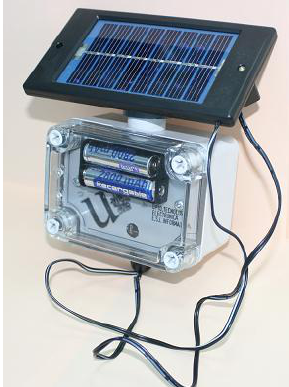
Figure 3. Node of the ARTICA 1